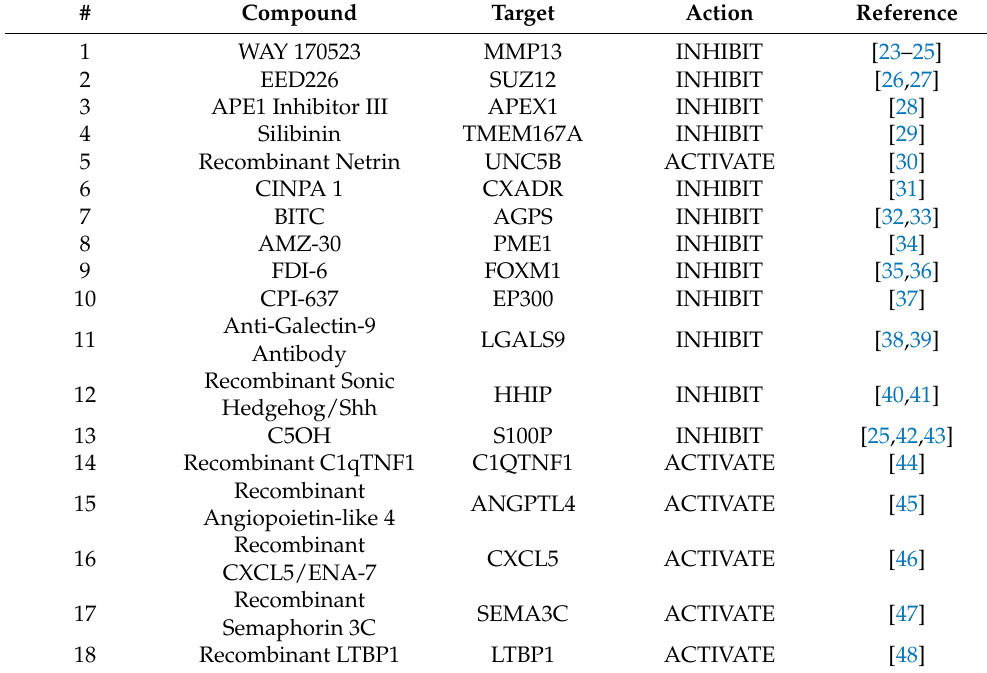
Table 2. Candidate compounds identified from transcriptome